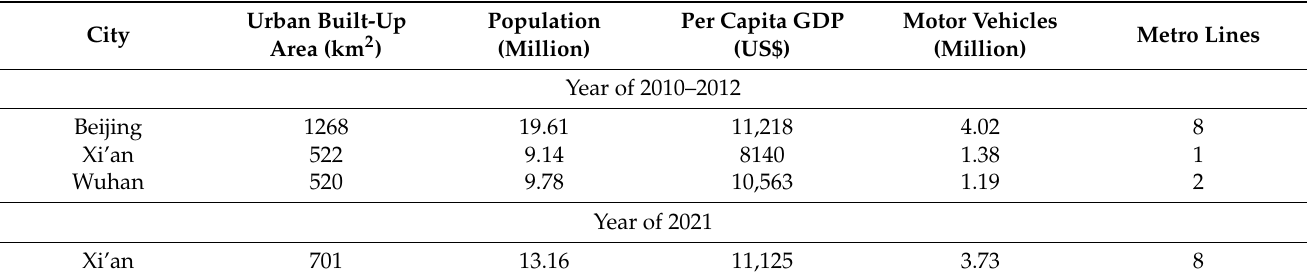
Table 1. General descriptions in the three case